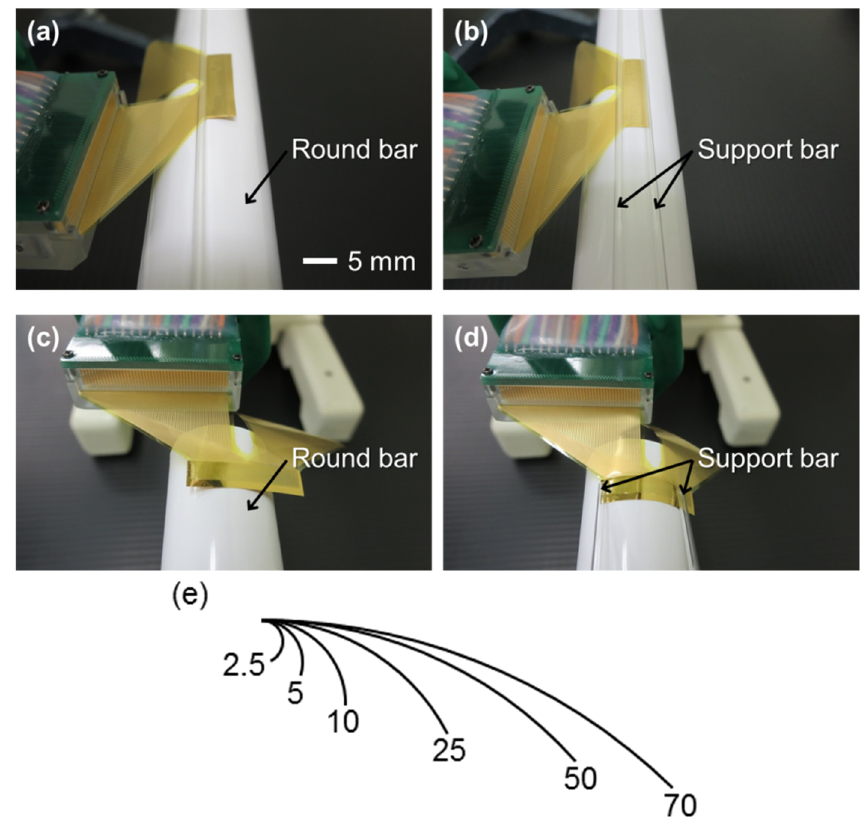
Figure 6. Bending test methodology: ( a , b ) photographs before and after bending about the X -axis; ( c , d ) photographs before and after bending about the Y -axis; and ( e ) actual size of the curvature radii (units: